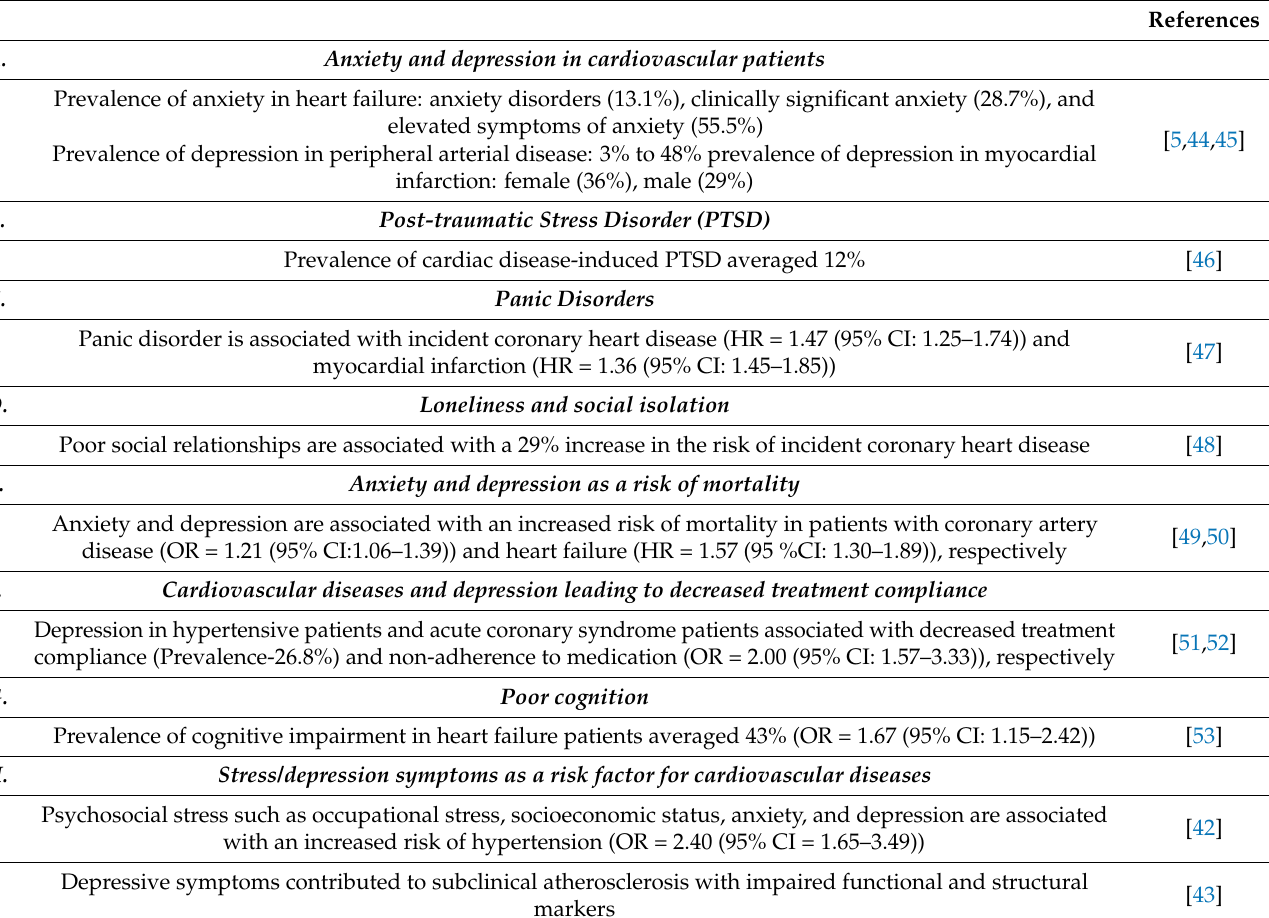
Table 2. Psychological backgrounds of patients with cardiovascular diseases.